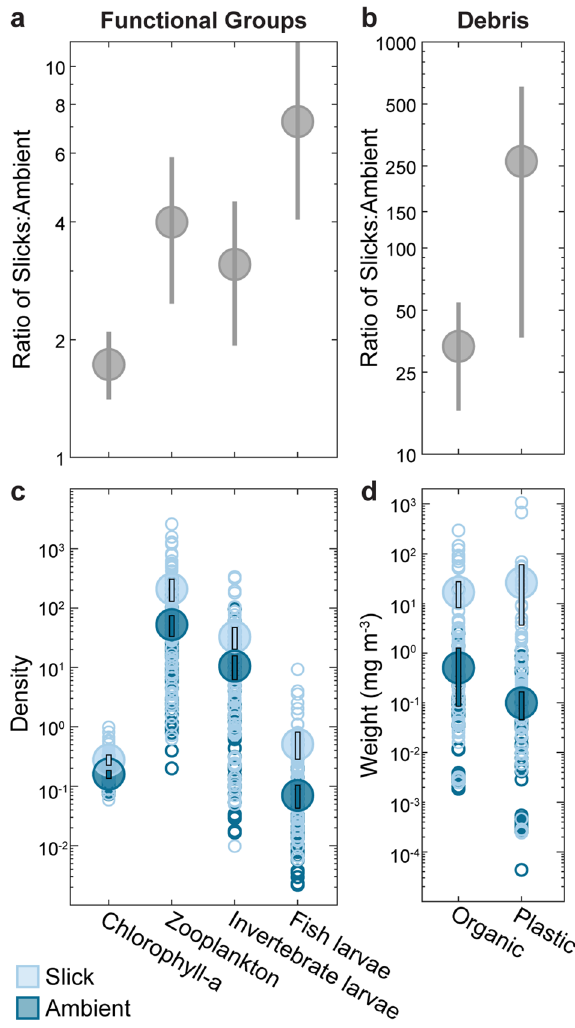
Figure 2. Densities and response ratios of major planktonic functional groups and debris in surface slicks compared to ambient waters. ( a ) Ratio of mean density in slicks to mean density in ambient water ± 95% bootstrap intervals (BI) for major planktonic functional groups (Supplementary Table S1). ( b ) Ratio of mean dry weight in slicks to mean dry weight in ambient water ± 95% BI for organic and plastic debris. ( c ) Mean (± 95% BI) densities of total zooplankton (i.e., including larvae and holozooplankton; individuals m −3 ), invertebrate larvae (individuals m −3 ), fish larvae (individuals m −3 ) and concentration of chlorophyll- a , (mg m −3 , a proxy for phytoplankton) (Supplementary Table S1). ( d ) Mean (± 95% BI) dry weight (mg m −3 ) of floating organic and plastic debris. Open circles indicate individual neuston tow samples in slicks (light blue) and ambient waters (dark blue) as follows: chlorophyll- a ( n = 44 slick, n = 27 ambient); zooplankton, invertebrate larvae, fish larvae, organic debris, plastic debris ( n = 80 slick, n = 54